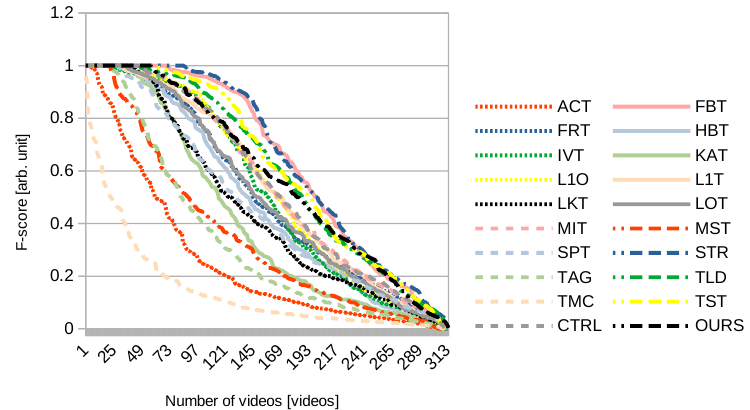
Figure 8. Comparison of F-score survival curves between using this work’s NCC (OURS) and the NCC implementation reproduced from [3,44] (CTRL). Other video trackers are shown for reference.